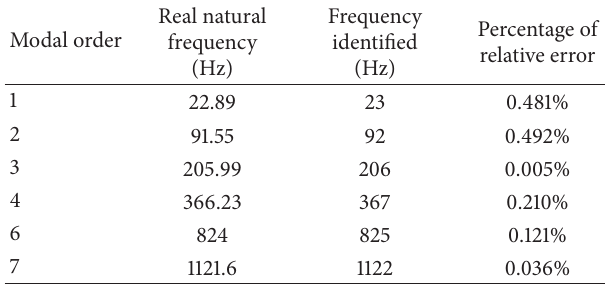
Table 8: The identified order and MAC value of modal shapes. Identified order